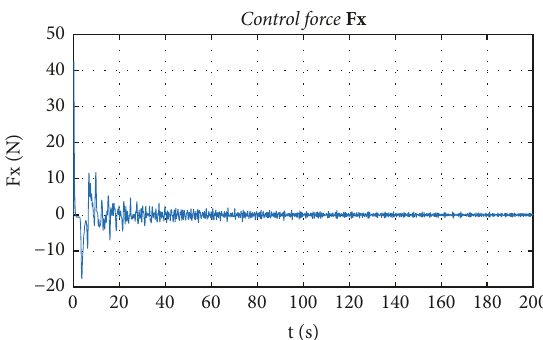
Figure 9: Control force 𝐹 𝑥 with vibration control.